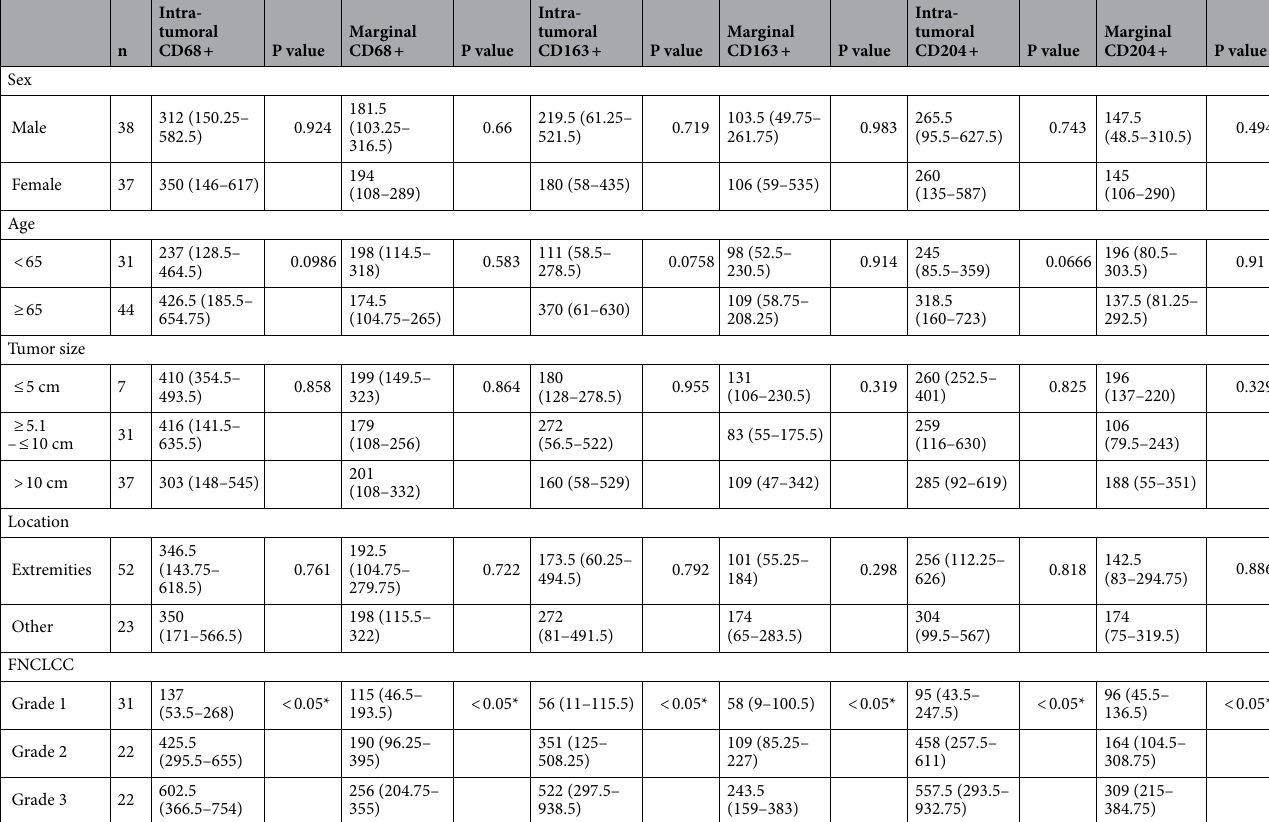
Table 3. Number of macrophages in the intratumoral and marginal areas, and their association with clinical factors. The number of intratumoral CD68 + , CD163 + , or CD204 + and marginal CD68 + , CD163 + , or CD204 + cells represent the average number of each phenotype in the intratumoral and marginal area. FNCLCC: Fédération Nationale des Centres de Lutte Contre le Cancer. *Kruskal–Wallis